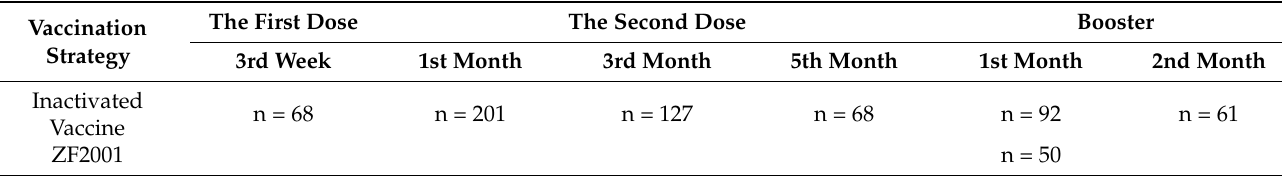
Table 1. The time points and information of serum